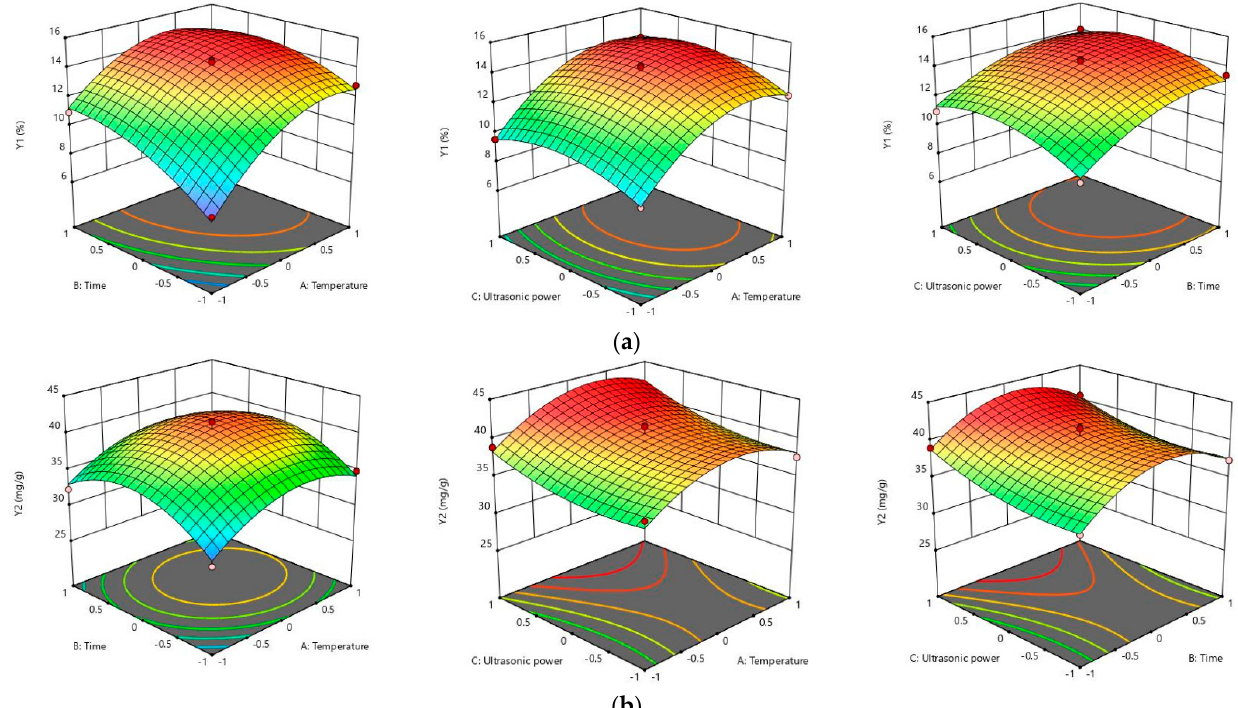
Figure 3. Response surface of the extraction yield ( a ) and TSC ( b ).